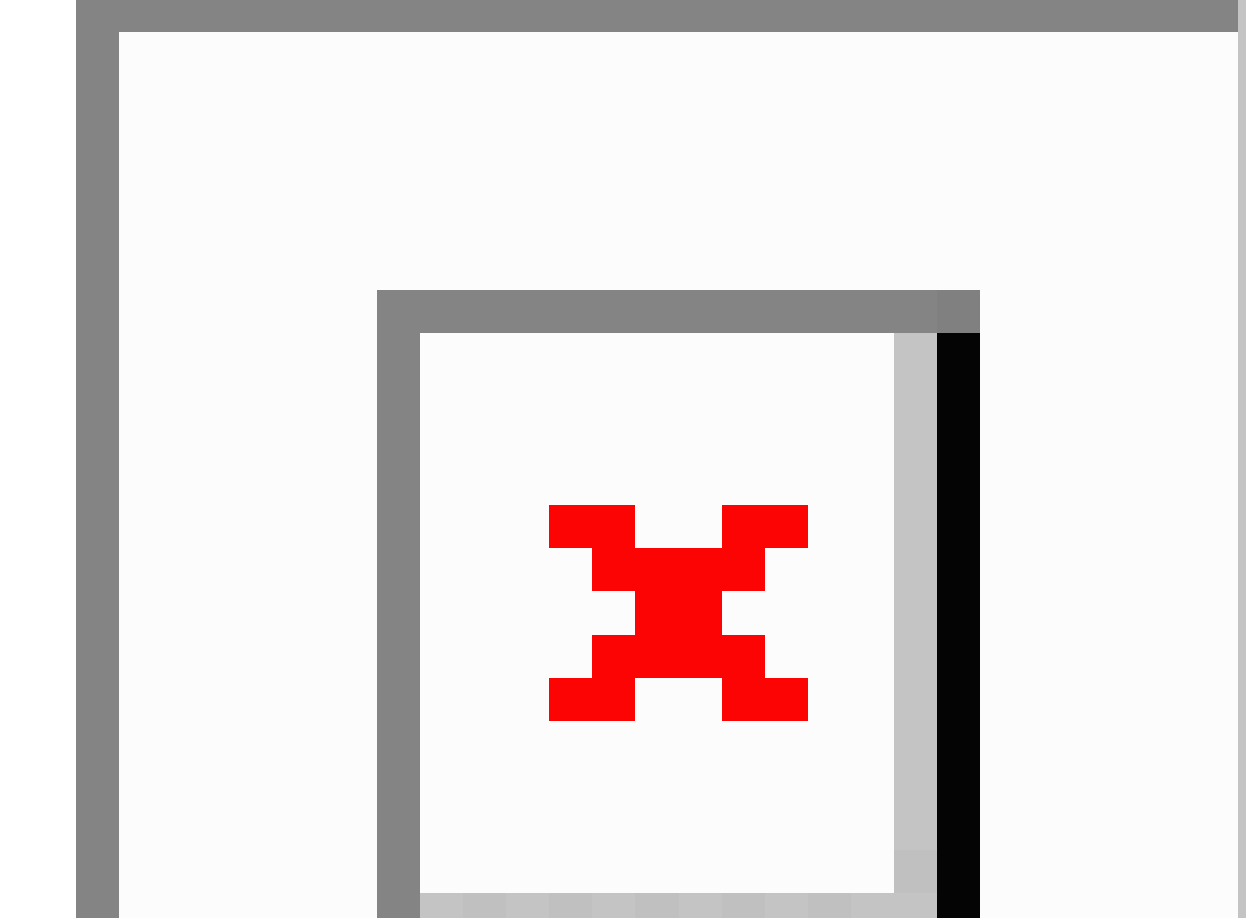
Figure 4. Number of users in the online albinism community per